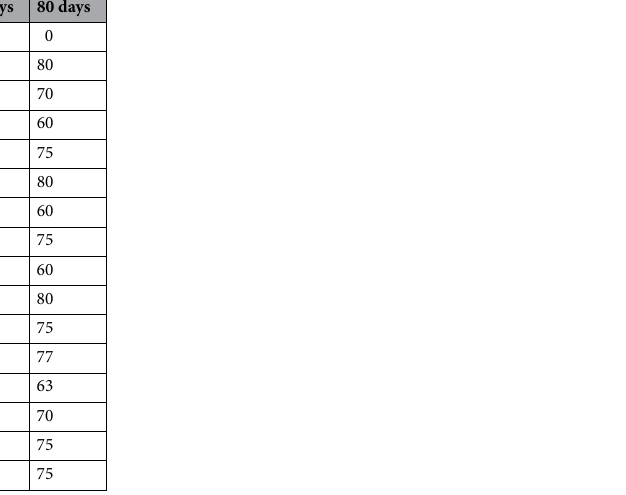
Leaf bio-assay, mortality percentage of Chilo infuscatellus larvae at different ages of transgenic plants Sugarcane plants